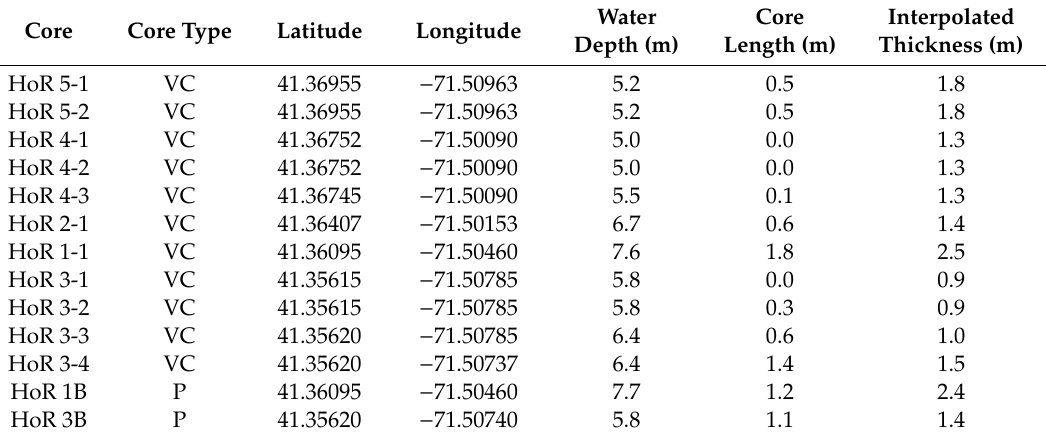
Table 2. Summary of core attempts. Core type is abbreviated; VC = vibracore; P = piston core Estimated sediment thickness from seismic reflection